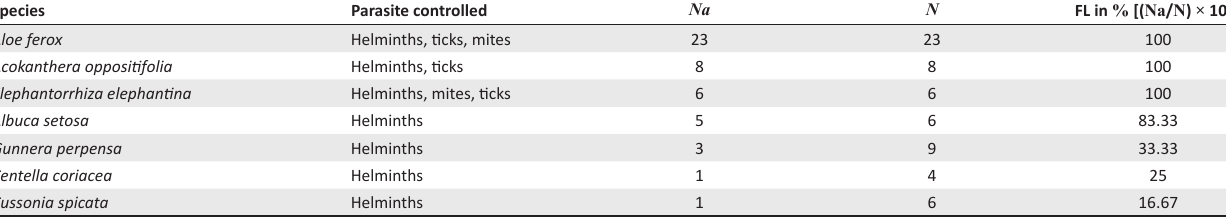
TABLE 1: Fidelity level indices of plant species used to control parasites in the study area. Species Parasite